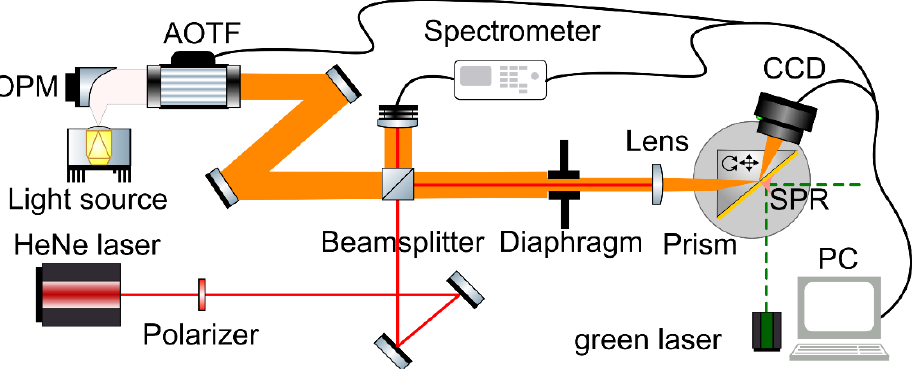
Figure 1. The optical scheme of the AOTF-based spectroscopy. The light source is the ISTEQ XWS-65 laser-pumped plasma broad white light radiation source collimated with the OPM (off-axis parabolic mirror) Thorlabs MPD399-M03 with a diameter of Ø 3 ” and reflected focal length = 9 ” ; HeNe laser is a helium-neon laser LGN-301 with an emission wavelength of 632.8 nm; Beamsplitter is a non-polarizing 50/50 cube with a 25 mm facet; Diaphragm is an 8 mm aperture for beam collimation; Lens is a Thorlabs achromatic lens Ø 1 ” with a spectral range of 400 – 700 nm and focal distance of 50 mm; Polarizer is a visible range polarizer; Spectrometer is a tunable grating spectrometer Avesta ASP-150 with Hamamatsu S8378-1024Q CCD array and a spectral resolution of 0.06 nm; Prism is a right-angle prism (produced at STC UI RAS) with base dimensions of 22 mm and height of 11 mm, made of LC-7 glass with a metal (silver, Ag) film and dielectric (silicon dioxide, SO 2 ) coating and placed on a rotating miniplatform Standa 7R7 mounted on a translation stage Standa 7T173 and vertical translation stage Standa 7VT188-20; CCD is a GigE monochrome industrial camera Imaging Source DMK 23G445 with no IR filter, with a resolution of 1280 × 960 pixels and sensitivity of down to 0.015 lx; PC is a personal computer with the control software written in Python 3 and AutoIt 3.